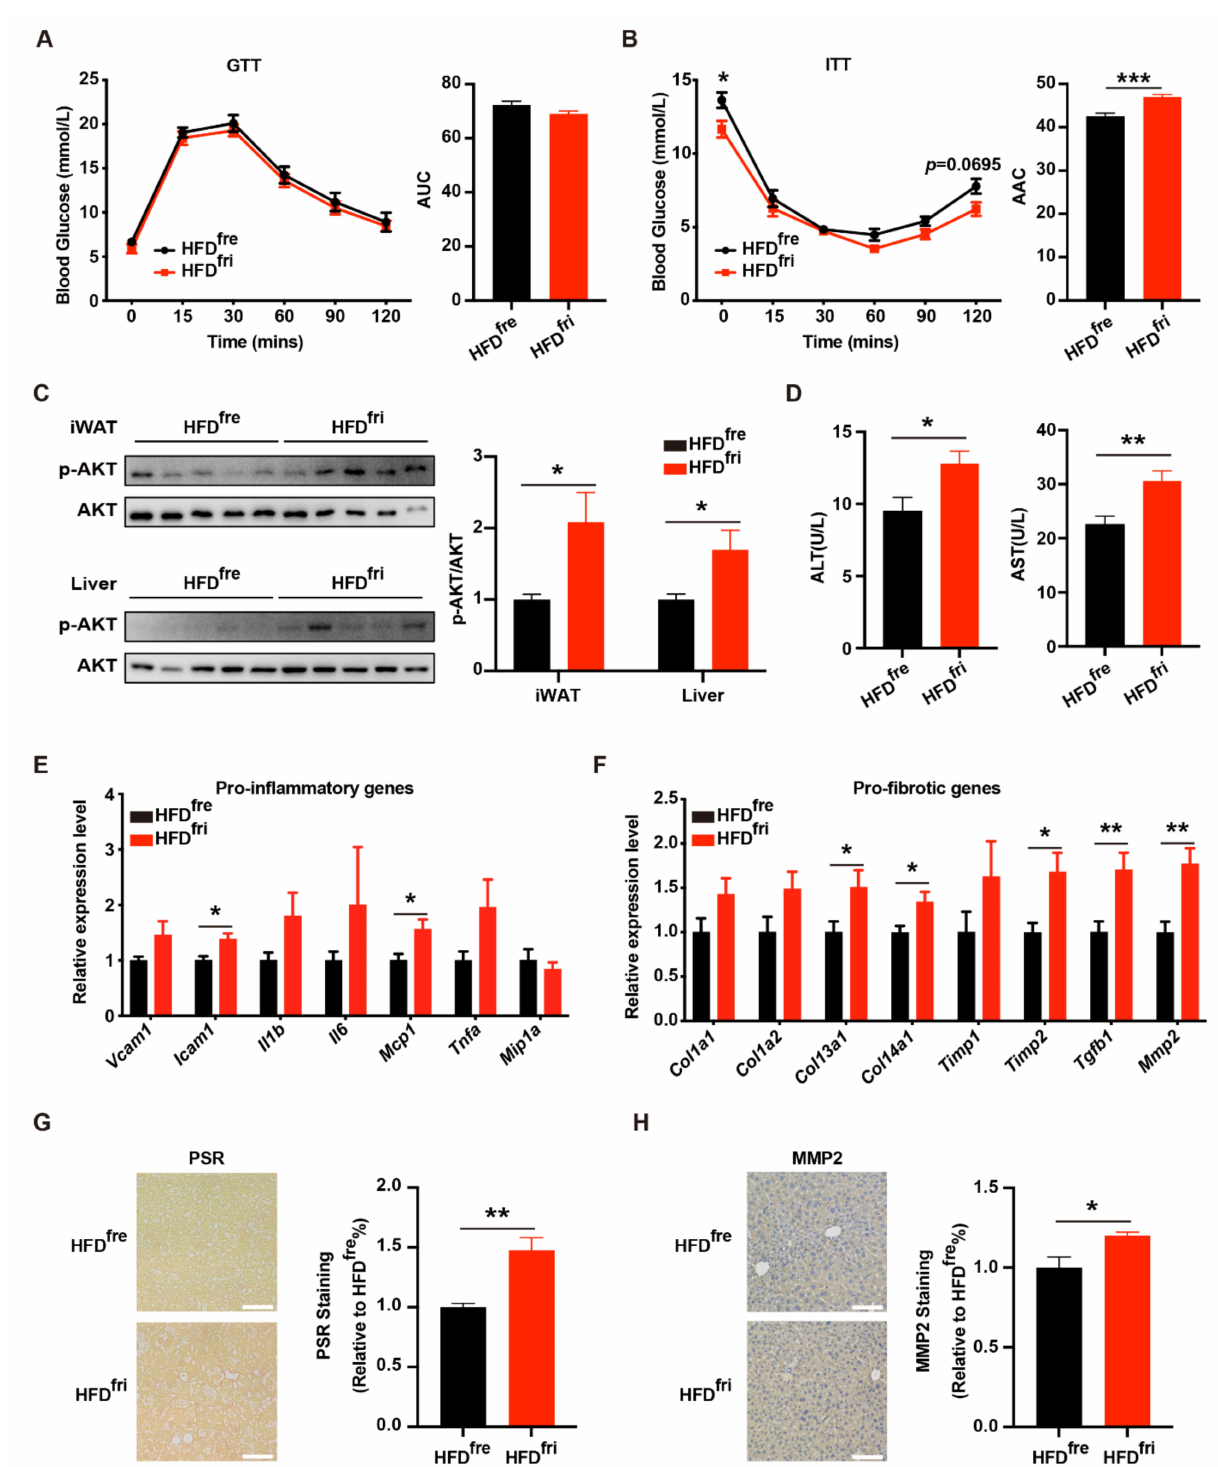
Figure 3. Exacerbated liver damage of the mice fed by high-fat diets (HFDs) stored in the fridge (fri) (HFD fri ). ( A , B ) Analysis of glucose metabolic conditions with ( A ) glucose tolerance test (GTT) ( p = 0.1480 from two-way ANOVA) and ( B ) insulin tolerance test (ITT) ( p < 0.0001 from two-way ANOVA) (for the high-fat diet (HFD) stored in the freezer (fre) (HFD fre ), n = 8; for the HFD stored in the fridge (fri) (HFD fri ), n = 7); ( C ) expression of phospho-protein kinase B ( p -AKT) in the liver, inguinal white adipose tissue (iWAT), and epididymal white adipose tissue (eWAT) in insulin